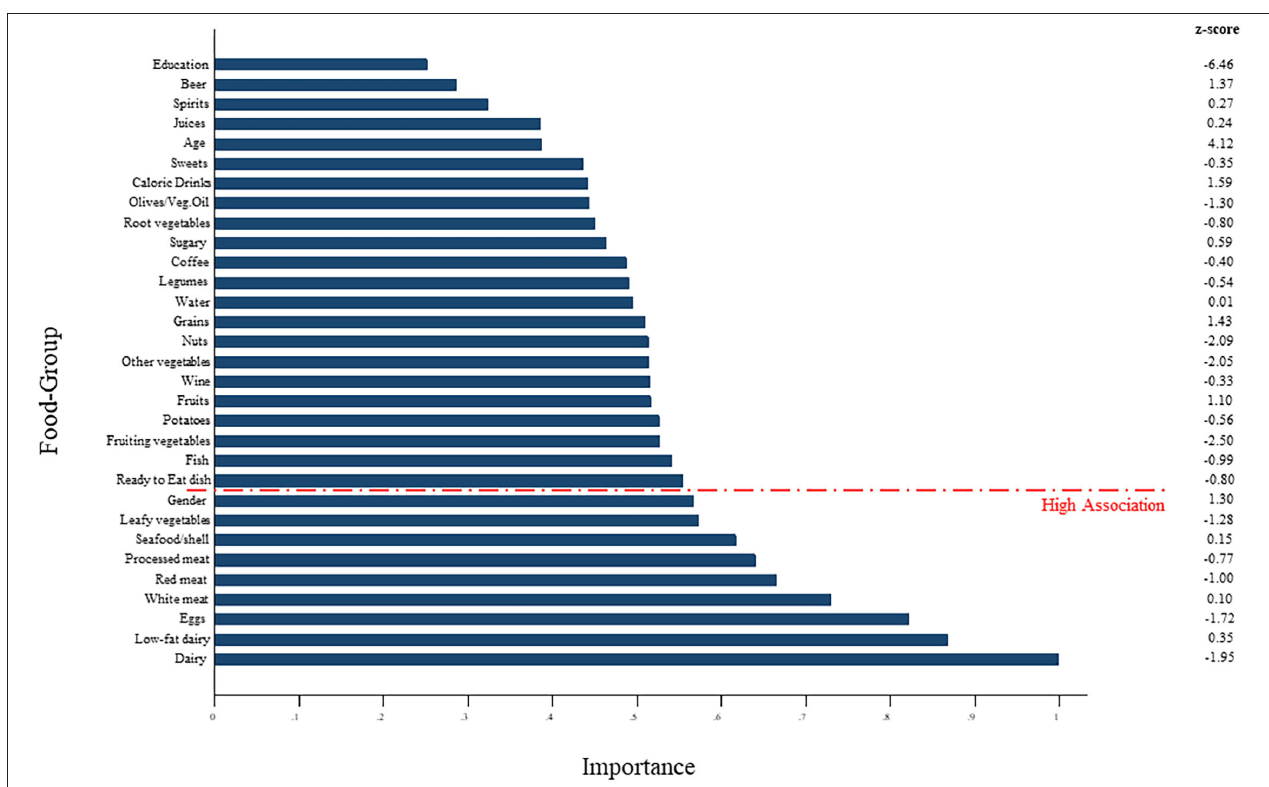
FIGURE 1 | Random Forest (RF) model used to identify a dietary pattern associated with social